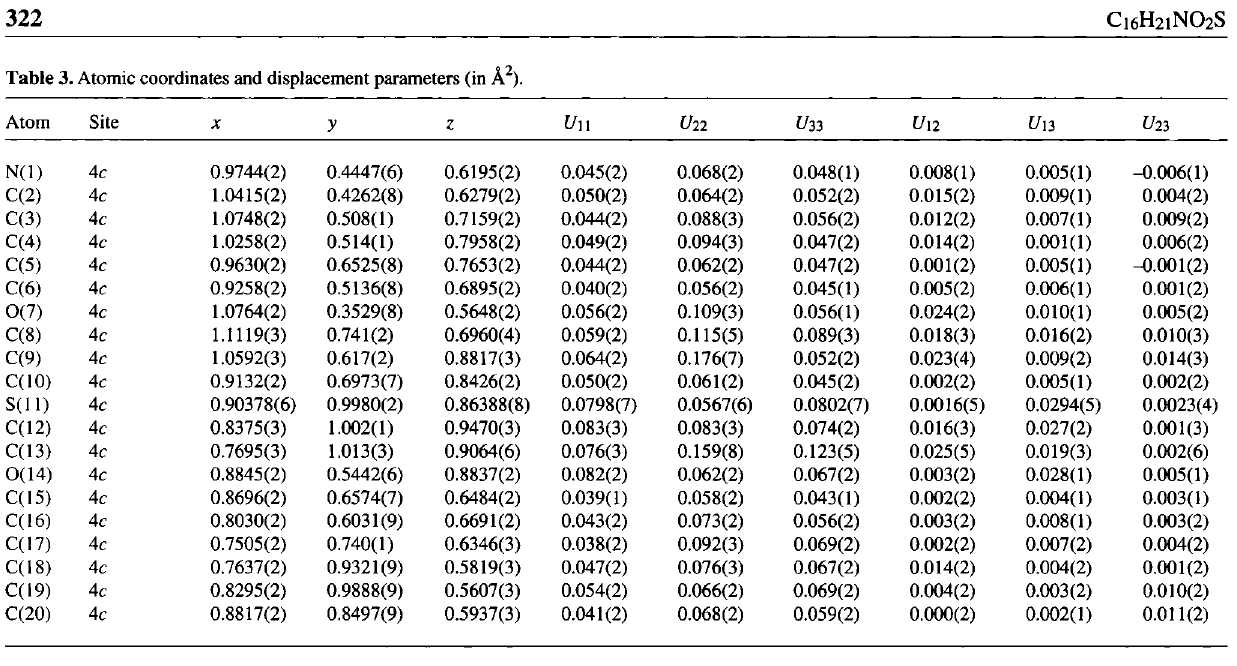
Table 3. Atomic coordinates and displacement parameters (in Â 2